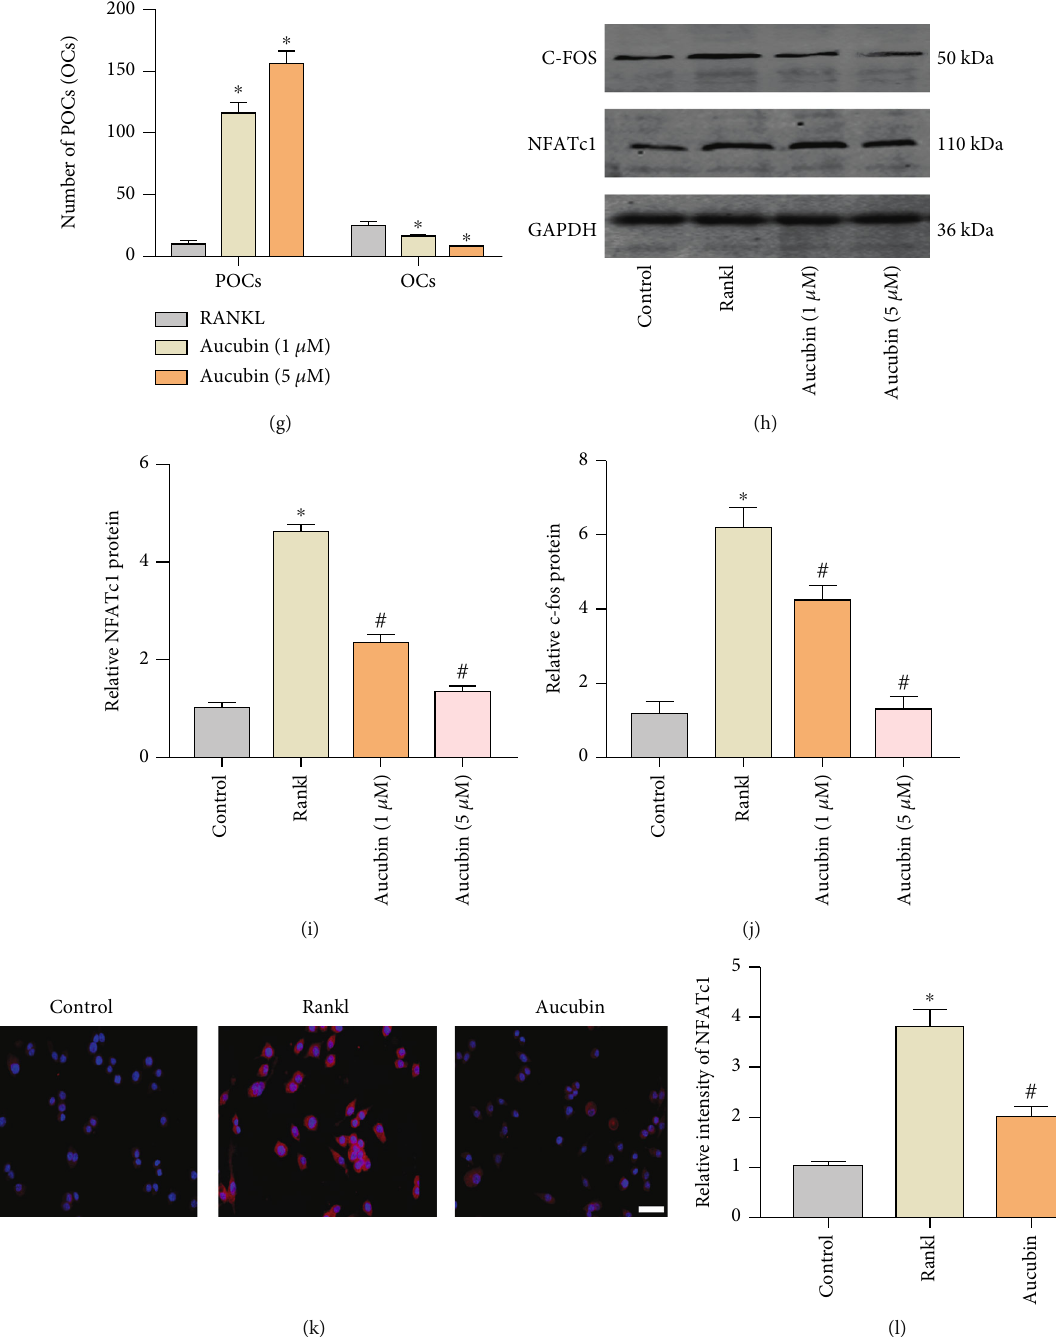
Figure 3: Aucubin increases the number of preosteoclasts in vitro. (a) Cell viability of RAW264.7 cells cultured with di ff erent concentrations of aucubin (0, 1 μ M, and 5 μ M) was analyzed via a CCK-8 assay. (b – e) Relative mRNA expression levels of NFATc1, c-FOS, DC-STAMP, and ATP6V0D2 were analyzed. (f) Representative images of TRAP staining on day 6. Scale bar: 200 μ m. (g) Quanti fi cation of osteoclasts (OCs) and preosteoclasts (POCs) on day 6. (h – j) Protein levels of c-Fos and NFATc1 were analyzed by WBs. (k) IF staining was performed to observe the location of NFATc1. Scale bar: 50 μ m. (l) The quanti fi cation of the relative NFATc1 fl uorescence intensity in di ff erent groups. ∗ P < 0 : 05 compared to the control group; # P < 0 : 05 compared to the Rankl